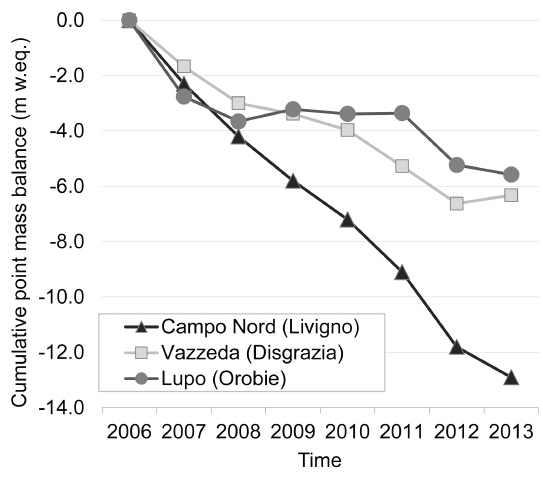
Figure 13. Cumulative point net mass balance in the Campo Nord (Livigno), Vazzeda (Disgrazia), and Lupo (Orobie) glaciers from 2007 to 2013 (see Table 5 for further